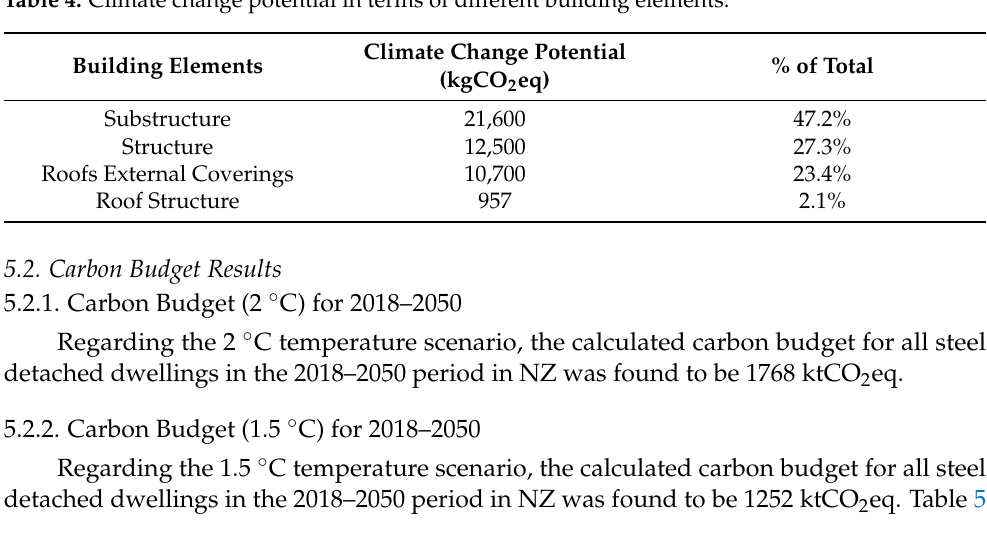
Table 4. Climate change potential in terms of different building